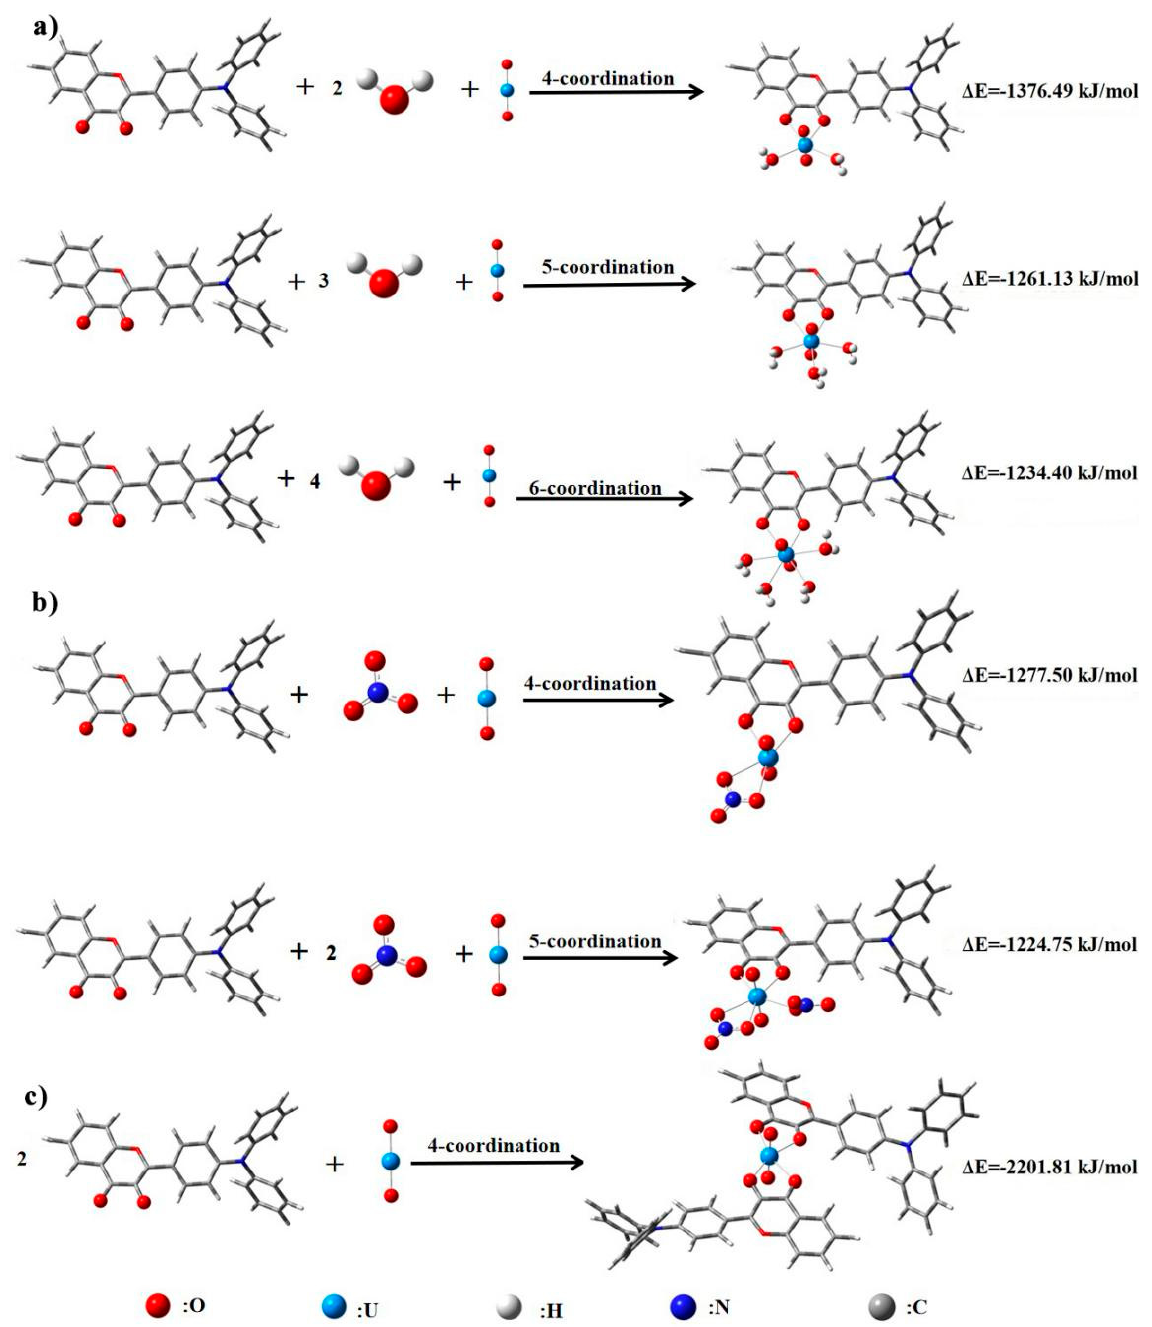
Figure 10. ( a ) Different coordination structures and binding energies between HTPAF and UO 22+ and H 2 O ( b ) Different coordination structures and binding energies between HTPAF and UO 22+ and NO 3 − ( c ) HTPAF: UO 22+ = 2:1 forms a 4-coordination structure model and binding energy.